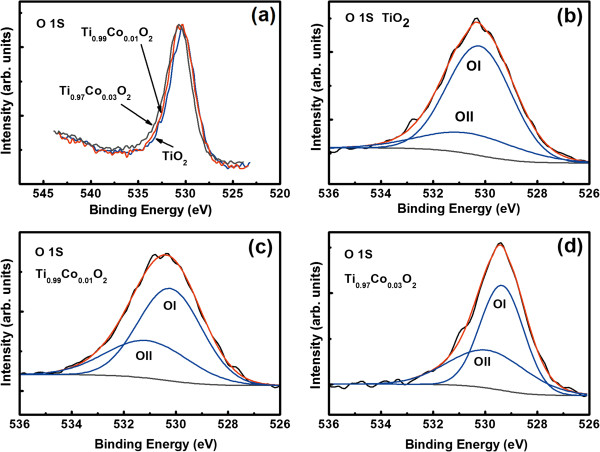
Normalized and fitted XPS core level spectra of oxygen 1 s level. Normalized XPS core level spectra of oxygen 1 s level of undoped and Co-doped TiO2(a). Fitted XPS core level spectra of oxygen 1 s level of TiO2 film (b), Ti0.99Co0.01O2 film (c), and Ti0.97Co0.03O2 film (d).